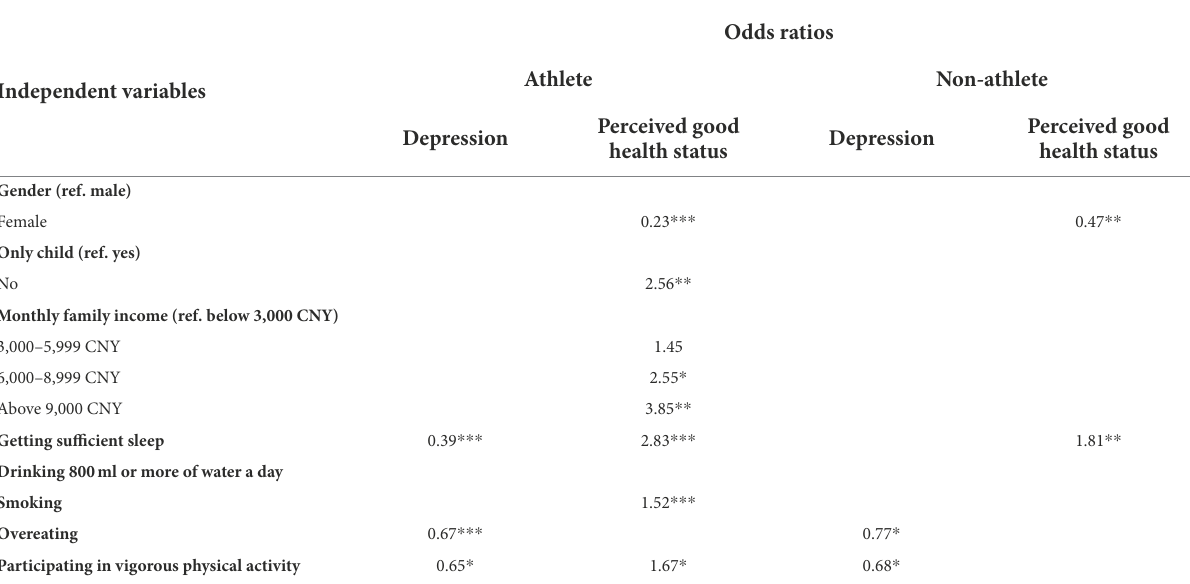
TABLE 4 Association of depression and perceived health status with demographic and behavioral